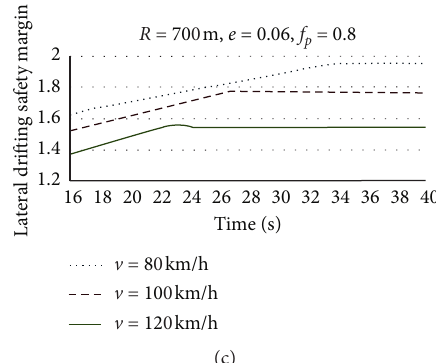
Figure 9: The effect of the significant single factor on the safety margin of the vehicle’s lateral drift. (a) Effect of superelevation on the safety margin of lateral drifting. (b) Effect of the peak friction coefficient on the safety margin of lateral drifting. (c) Effect of speed on the safety margin of lateral